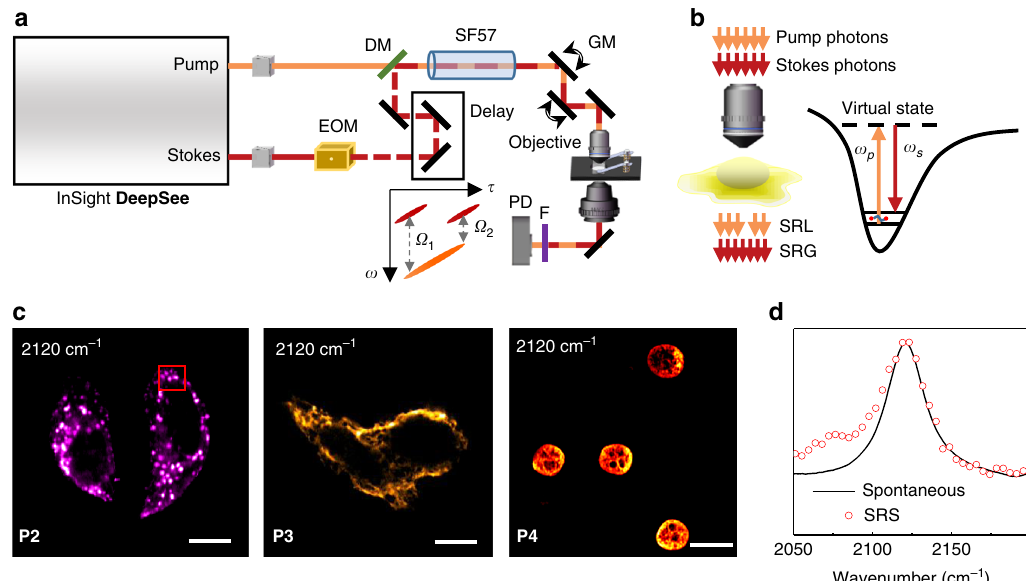
Fig. 6 Illustration of the SRS system and SRS images of fi xed HeLa cells. a Schematic illustration of the instrumental setup of the SRS imaging system. EOM: electro-optic modulator; DM: dichroic mirror; GM: galvanometer; F: optical fi lters; PD: photodiode. b Stimulated Raman transition process for vibrational imaging of HeLa cells stained by PDDA-based tags. c SRS images (2120 cm − 1 ) of fi xed HeLa cells treated with 50 μ M of P2 , P3 , and P4 , respectively. Scale bar: 10 μ m. d SRS spectrum of the HeLa cell sample stained with P2 in the red box region in ( c ), the spontaneous Raman spectrum of P2 in aqueous solution shown as a reference.